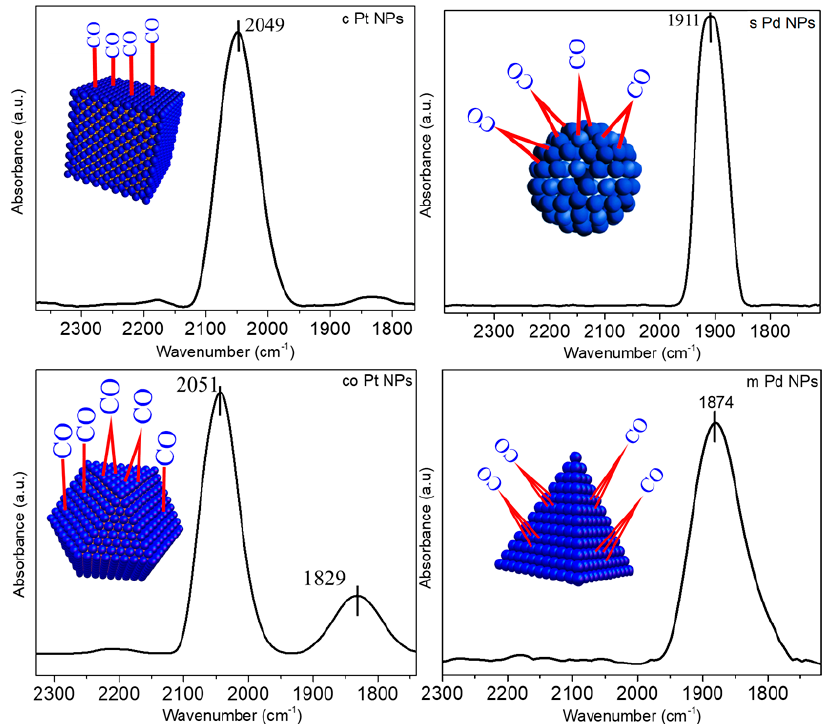
Figure 7. FTIR spectra of Pt and Pd NPs supported on ZrO 2 , exposed to 10 mbar CO at room temperature; spectra acquired after evacuation. Adsorbate species are schematically illustrated.